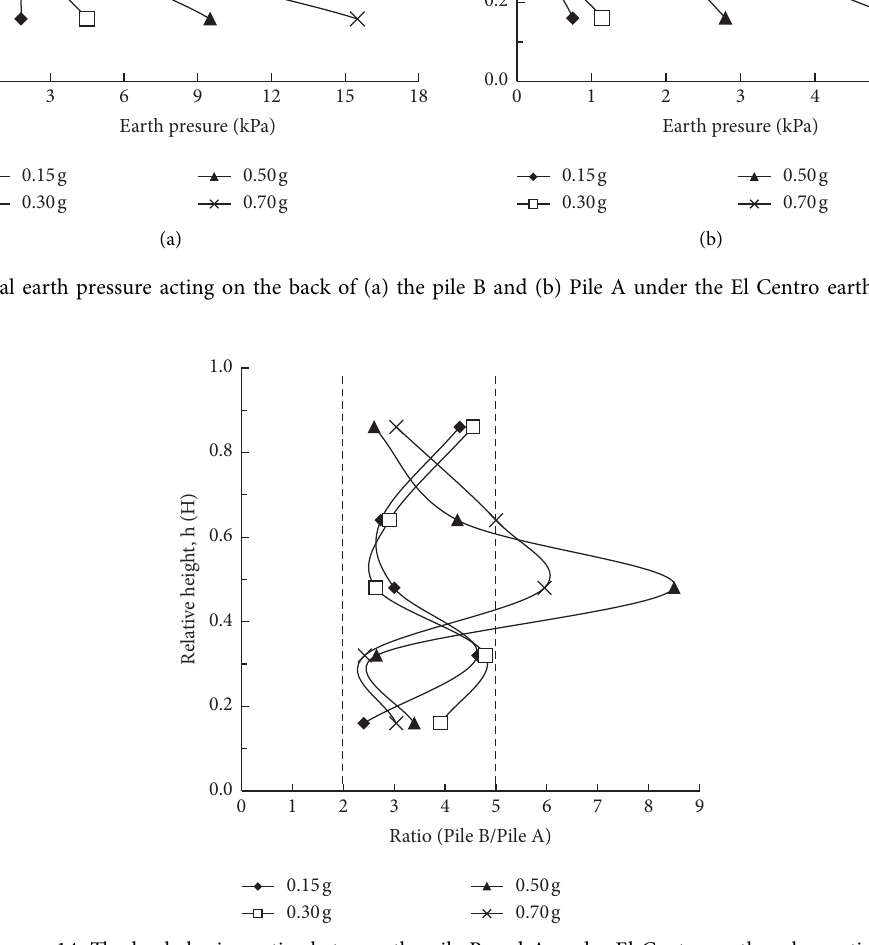
Figure 14: The load-sharing ratios between the pile B and A under El Centro earthquake